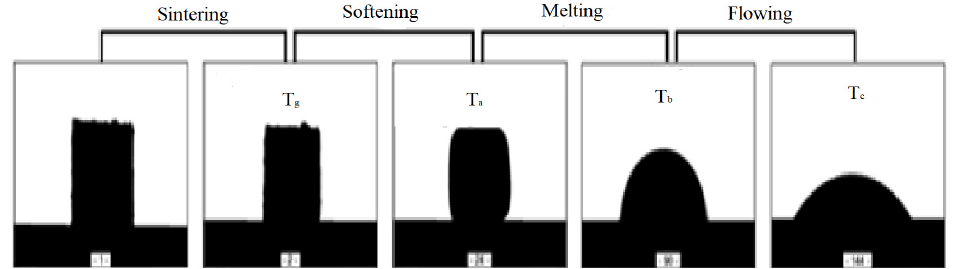
Figure 2. Method of determining characteristic temperatures and intervals in high-temperature microscopy, original state of sample 1 (spodumene Gresflux).